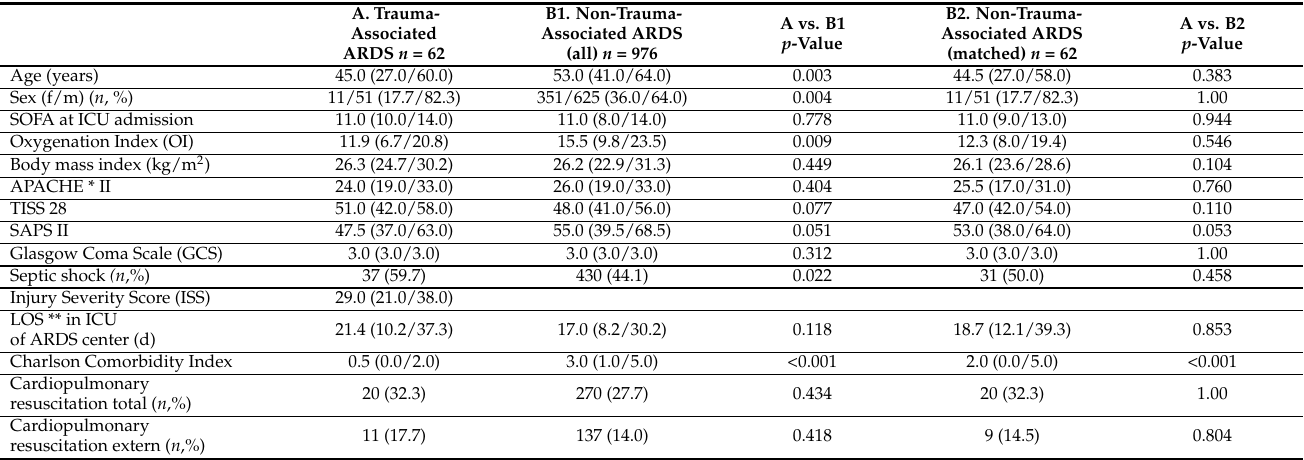
Table 1. Baseline